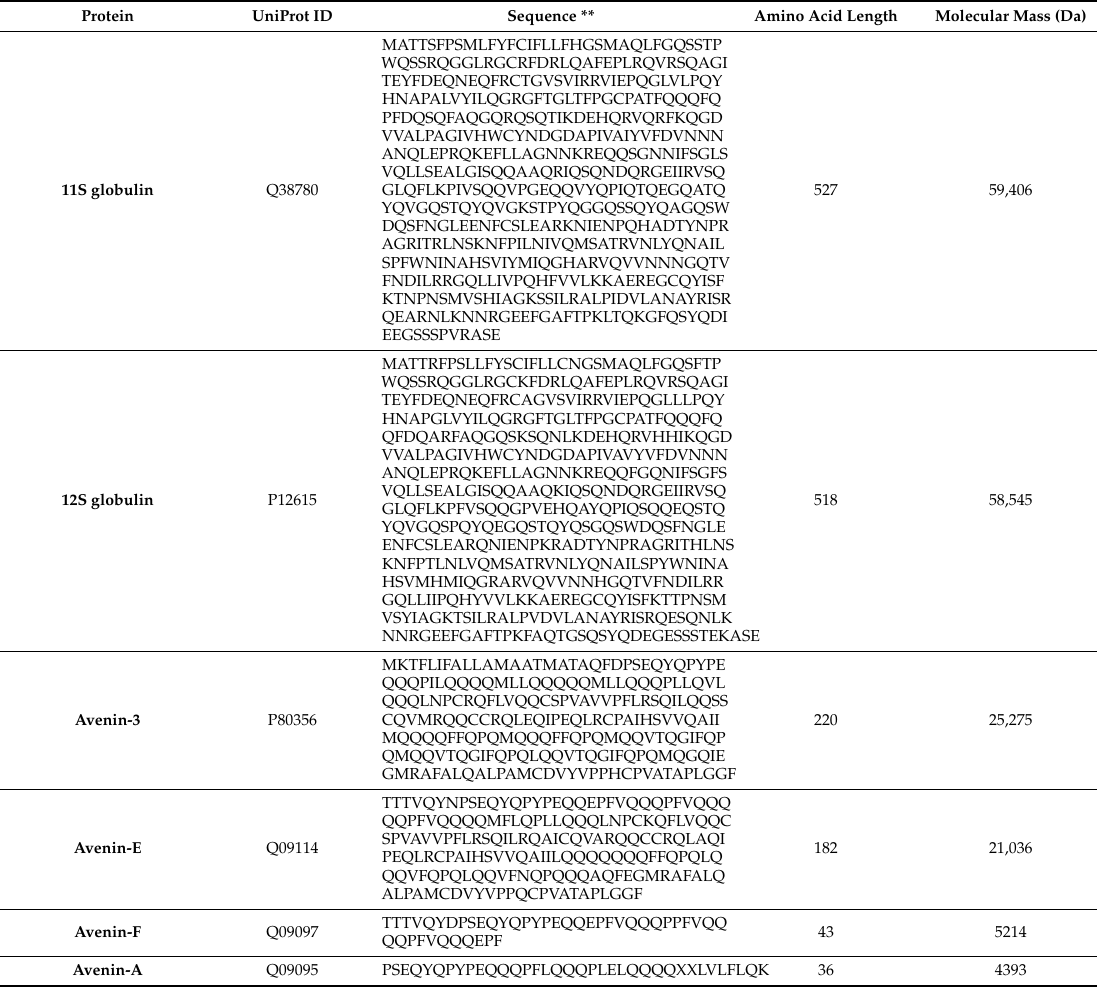
Table 1. The main storage proteins found in